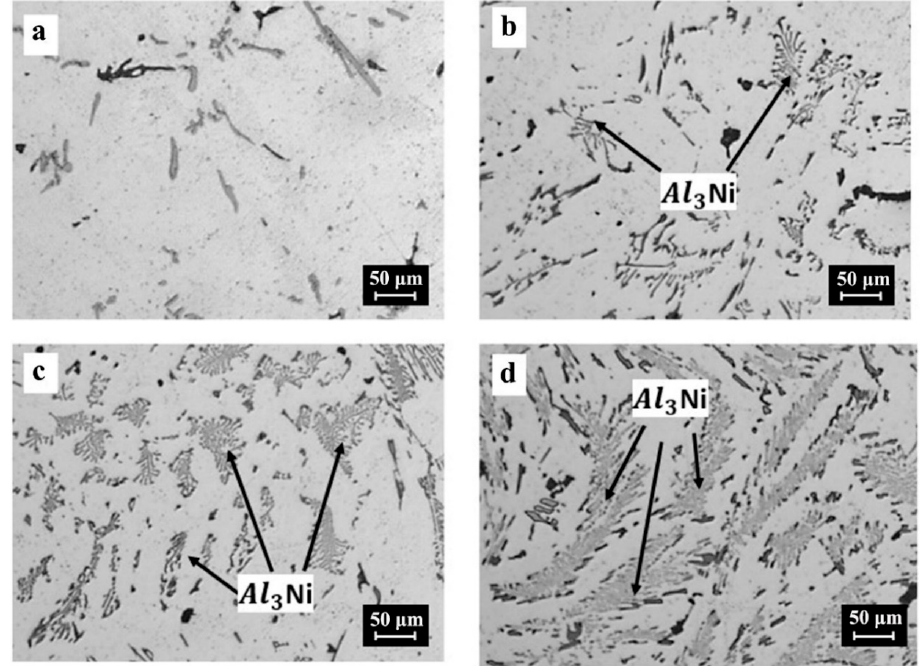
Figure 6. Photomicrographs of Al-Ni samples obtained at 1123 K, as a function of injection time, where ( a ) 0 min, ( b ) 20 min, ( c ) 40 min, and ( d ) 90 min.